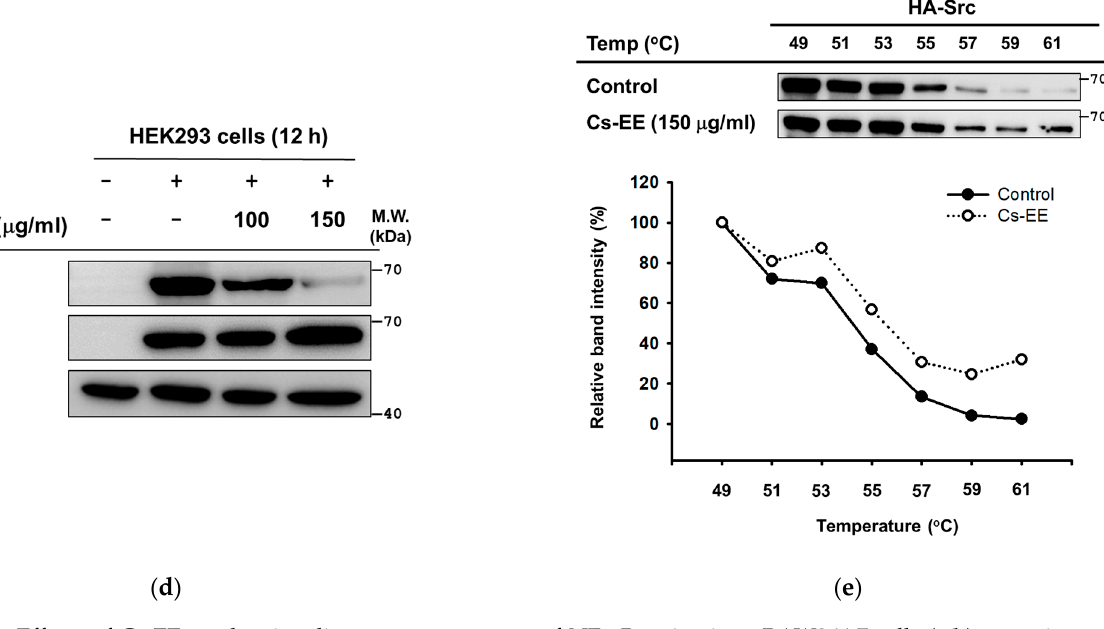
Figure 4. Effects of Cs-EE on the signaling events upstream of NF- κ B activation. RAW264.7 cells ( a and b ) or peritoneal macrophages ( c ) were pre-treated with 150 μ g/mL Cs-EE for 30 min, followed by with or without LPS induction at certain time points. The phosphorylated and total protein levels of I κ B α , p85, Src, TAK1, and β -actin were evaluated by immunoblot analysis. ( d ) The phosphorylation of Src was evaluated in HEK293 cells following Src overexpression by transfection of HA-Src construct for 24 h and then treatment with Cs-EE (100 and 150 μ g/mL). ( e ) CETSA was conducted in Src-overexpressing HEK293 cells treated with DMSO (control) or Cs-EE (150 μ g/mL) at different heating temperatures. The interaction between Cs-EE and Src was analyzed by immunoblot analysis, and then quantification of band intensity was measured by ImageJ.